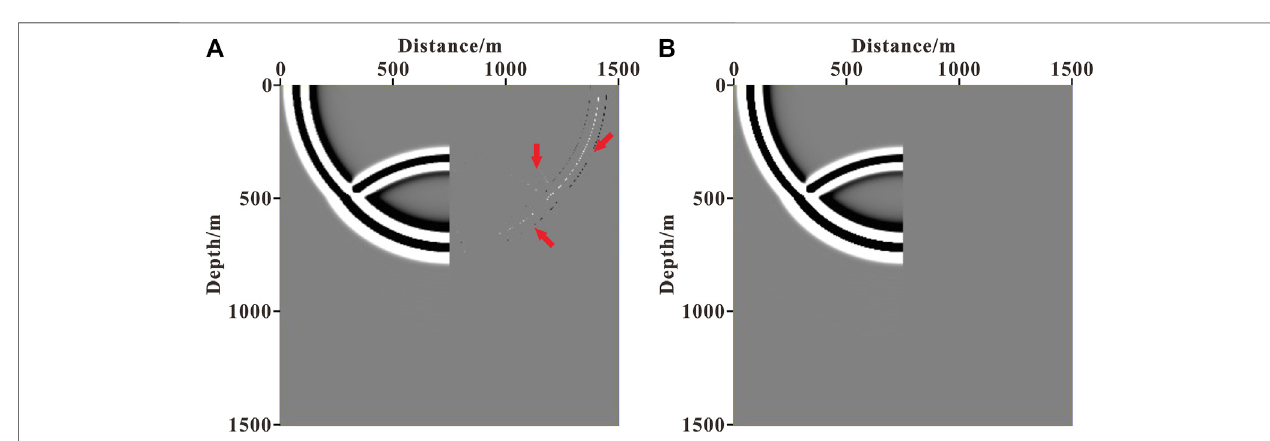
Frontiers in Earth Science |